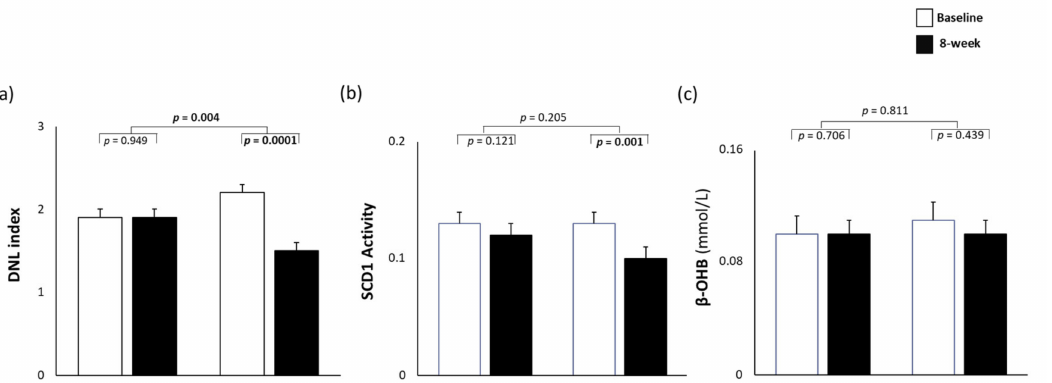
Figure 1. DNL index ( a ), SCD1 activity index ( b ), and plasma β -hydroxybutyrate concentration ( c ) at baseline and after the 8-week intervention with a MUFA diet ( n = 20) or multifactorial diet ( n = 17). MUFA, monounsaturated fatty acid; β OHB, β -hydroxybutyrate; SCD1, stearoyl-CoA desaturase. Data are presented as mean ± SEM.